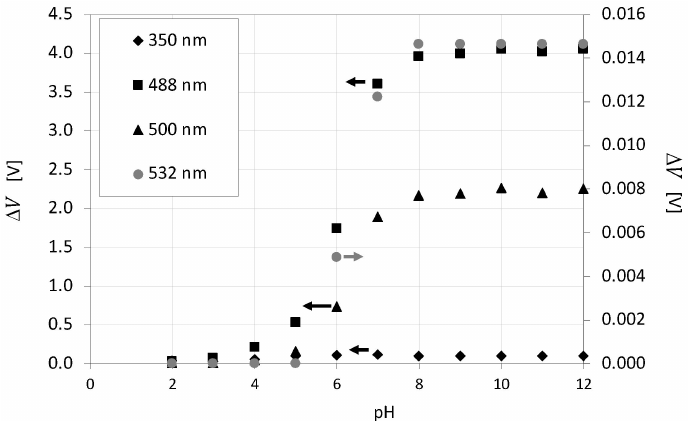
Figure 4. Influence of pH on electric potential difference measured for 20 mg · L − 1 fluorescein solution at 25 ◦ C, for 350, 488 nm, 500 nm and 532 nm.